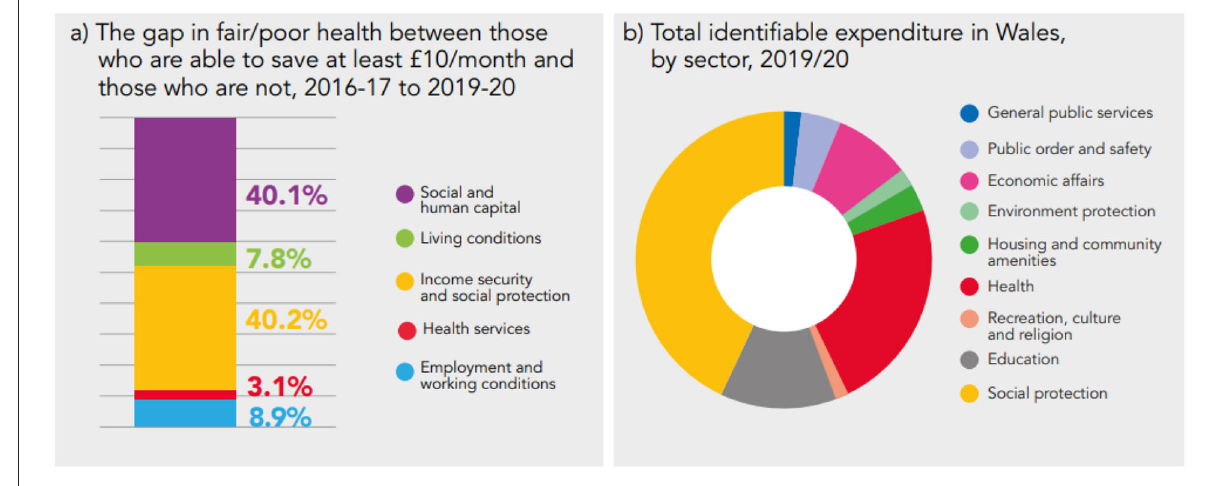
FIGURE9 Comparing findings from the decomposition of the health gap (a) to government expenditure data (b)